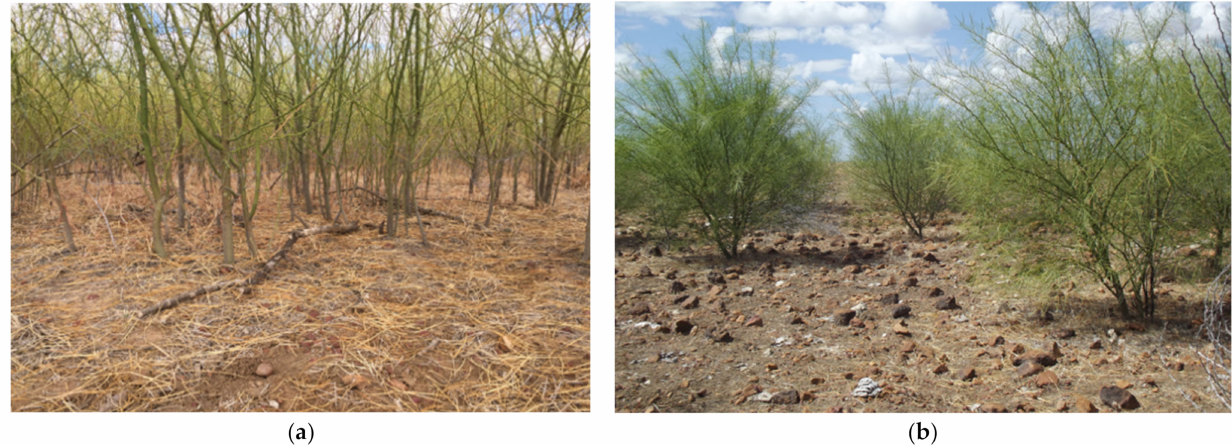
Figure 11. ( a ) Densely crowded healthy parkinsonia plants in north infestation; ( b ) free-standing healthy parkinsonia in south infestation at trial